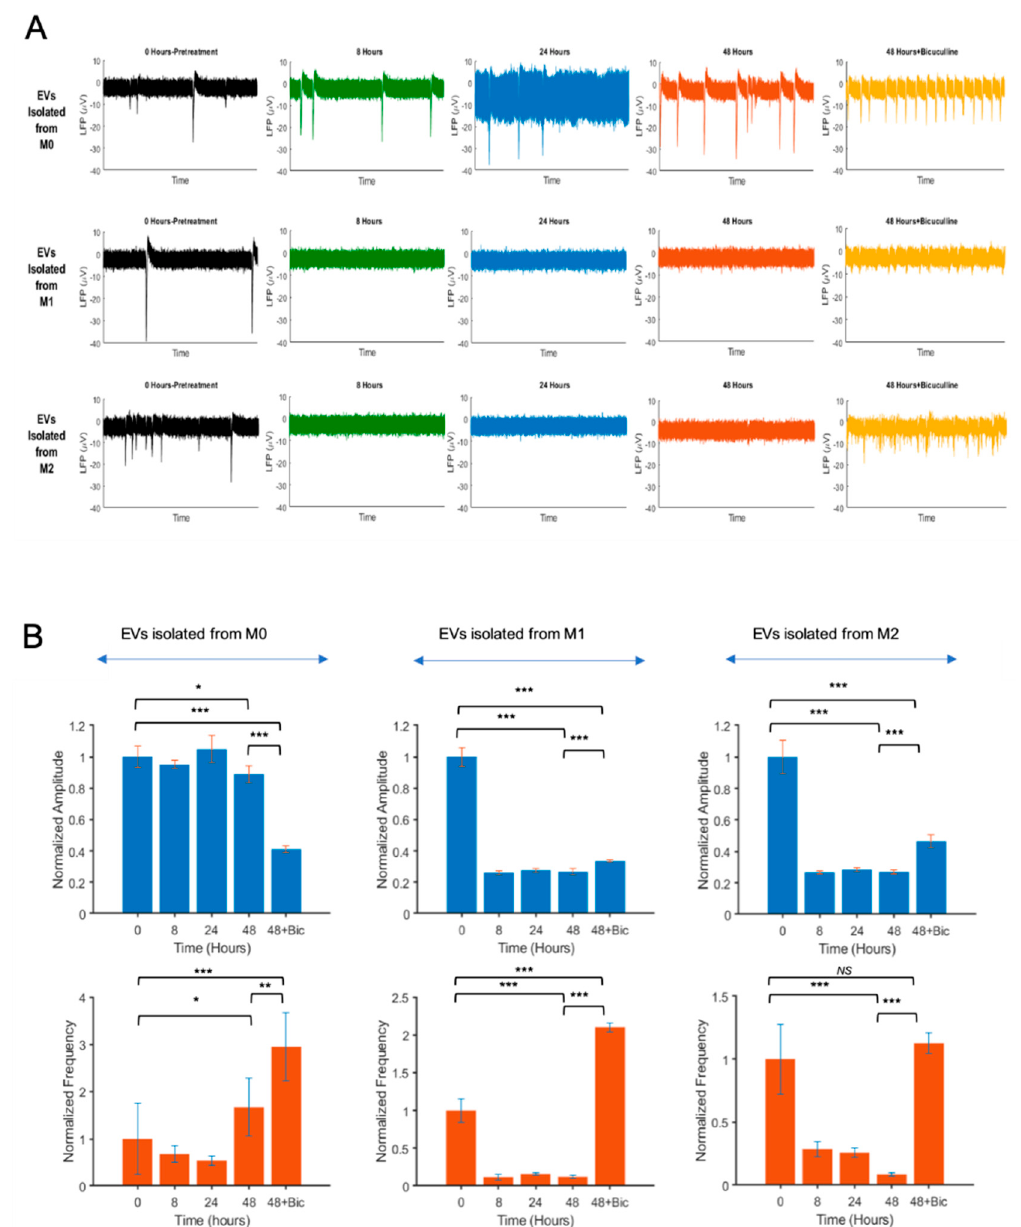
Figure 5. E ff ect of EVs isolated from M0, M1, and M2 on neuronal activity by microelectrode array studies (MEA). ( A ) Extracellular action potential recordings of primary rat neurons treated with EVs from M0, M1, and M2 macrophages. Rat hippocampal neurons were dissociated from the hippocampi of E18 prenatal rat embryos and placed onto the MEA dishes. Experimental recordings and EV treatments were started when the cultures were 21 days old. After placing the MEAs on the amplifier, recordings were performed using the MC_Rack software. The recorded electrophysiological activities are shown for a 60-s duration of the recordings. The recorded spiking data (in µ V versus time) were transferred to the MATLAB environment for further o ffl ine analysis. Top row: M0-Evs at t = 0, 8, 24, and 48 h. Middle row: M1-EVs treated neurons at t = 0, 8, 24, and 48h. Bottom row: M2-EVs treated neurons at t = 0, 8, 24, and 48 h. At 48 h posttreatments, cells were also treated with bicuculline and recorded. ( B ) Time-dependent variations of the normalized firing frequency and amplitude of cells treated with EVs isolated from M0, M1, and M2 macrophages are shown as bar graphs. ( n = 3; * p ≤ 0.05, ** p ≤ 0.01, and *** p ≤ 0.001).